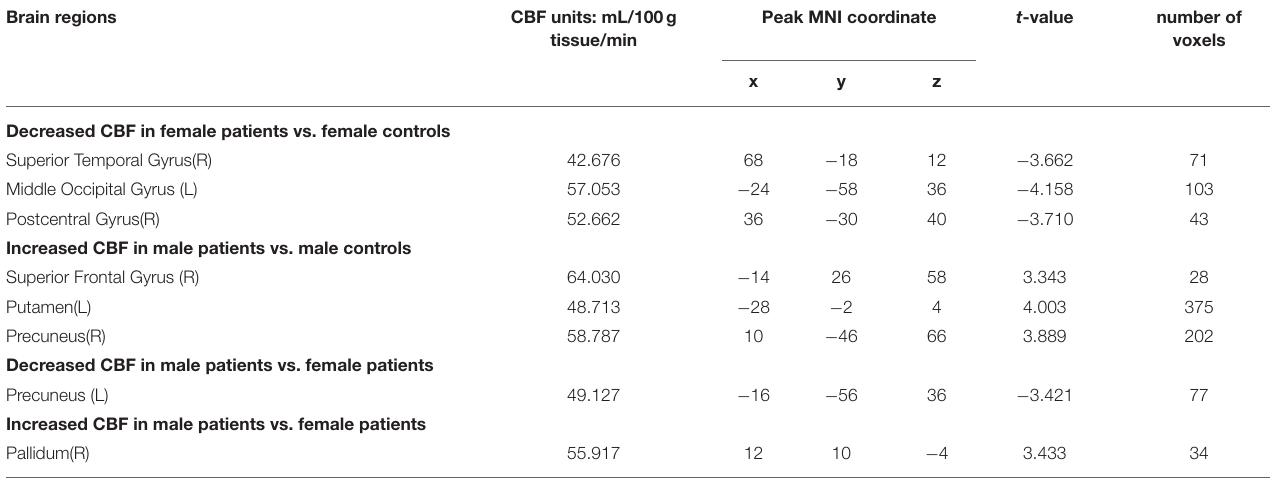
TABLE 4 | The significantly altered CBF brain regions between the patients with mTBI and healthy controls. Brain